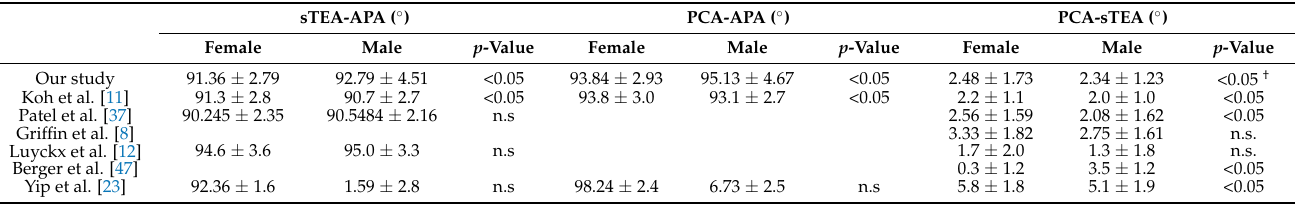
Table 5. Comparison of gender differences in the angle between the axes used in mechanically aligned total knee arthroplasty with those in other